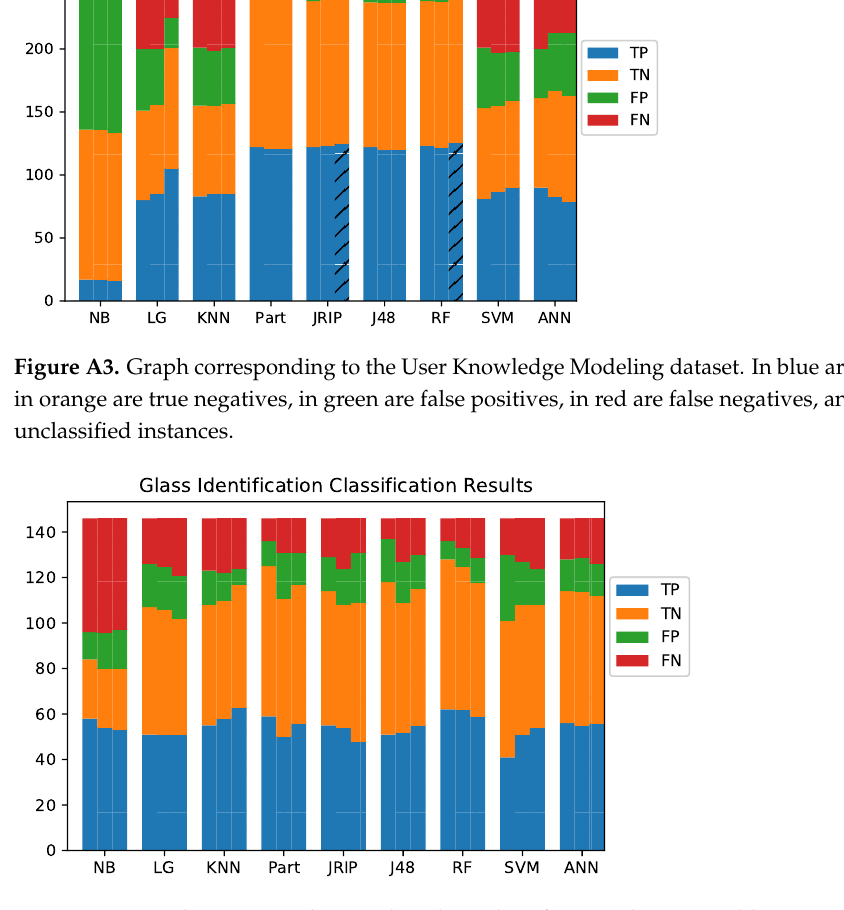
Figure A4. Graph corresponding to the Glass Identification dataset. In blue are true positives, in orange are true negatives, in green are false positives, in red are false negatives, and in purple are unclassified instances.